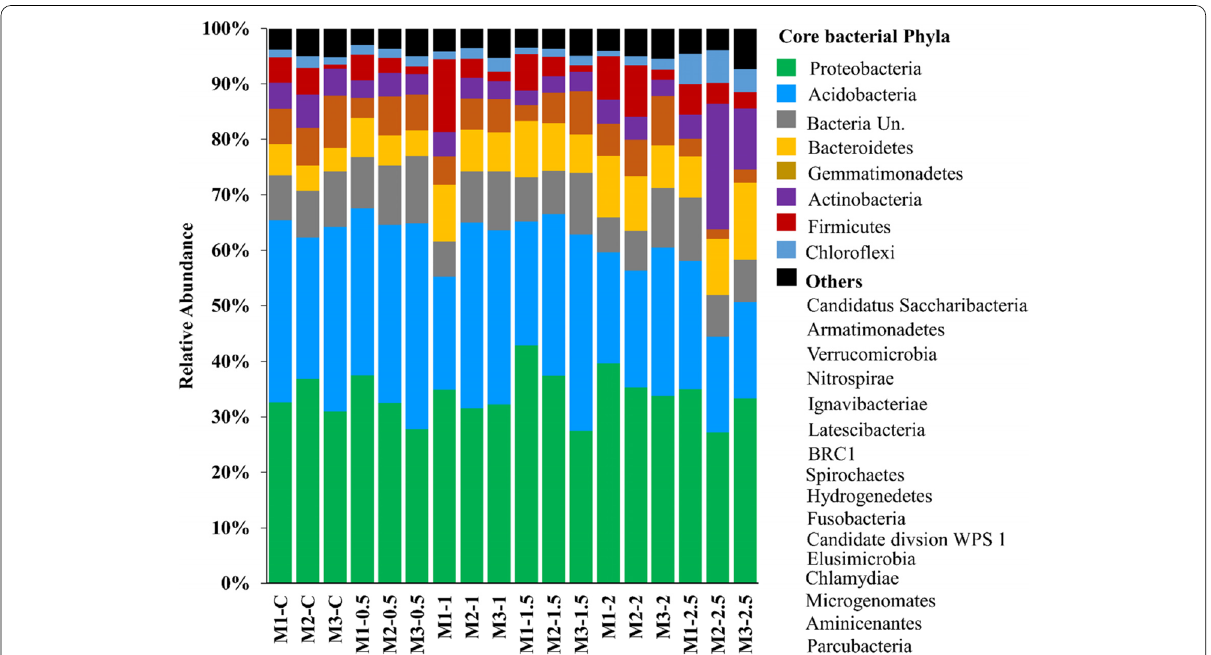
Fig. 4 Relative abundance (%) of bacterial phyla depicting increase or decrease in the non-amended and sclerotia-amended soil samples in rice-rapeseed rotation field soil amended with different doses of R. solani sclerotia detected using 16S rRNA sequencing. M1, M2, and M3 represent 1 st month, 2 nd month, and 3 rd month while C shows the non-amended samples. Moreover, 0.5, 1, 1.5, 2 and 2.5 denotes the different dose of sclerotia in gram amended in